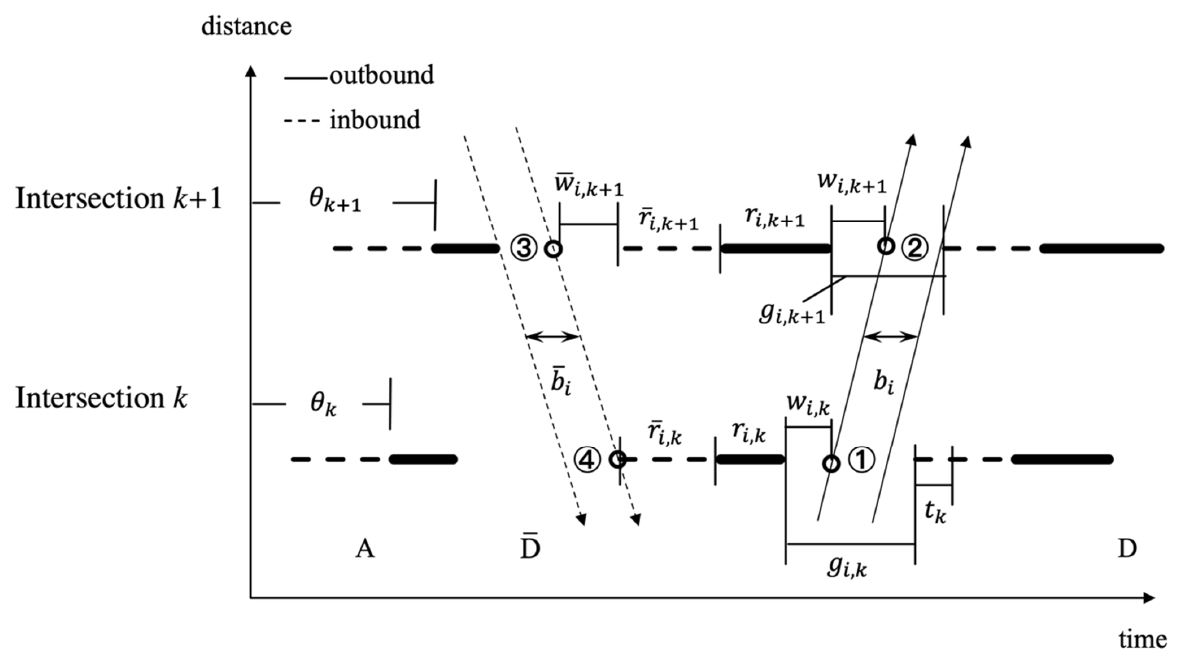
Figure 6. Explanation of key variables.